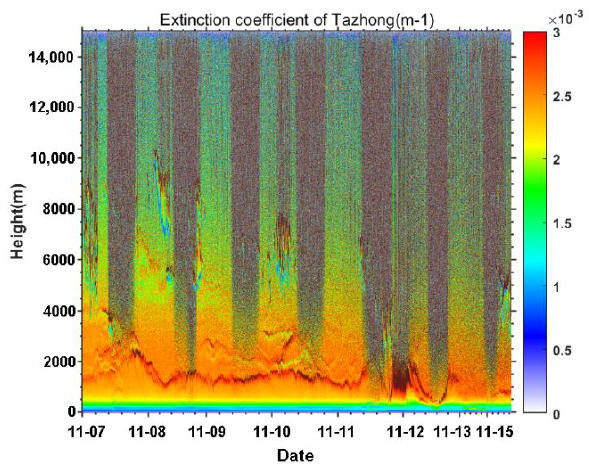
Figure 4. Time series of the extinction coefficients during the observation periods at Tazhong in the TD.